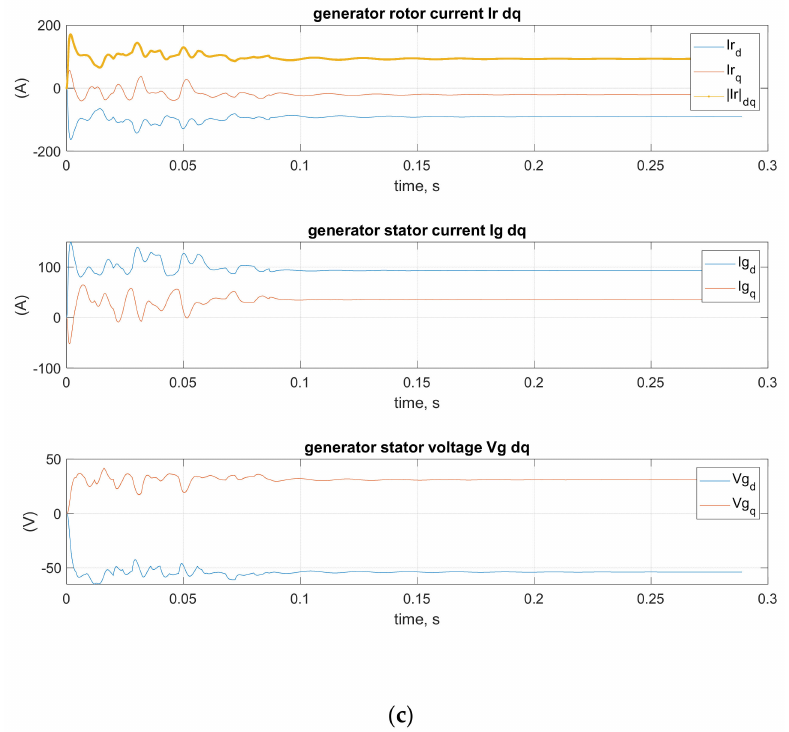
Figure 24. Dq coordinates of rotor current I r , stator current I g and stator voltage V g of DFIG generator: